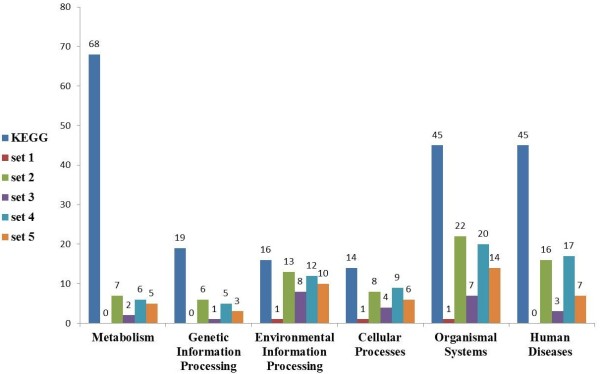
The distribution of KEGG pathways with modules among the main KEGG categories for parameter sets 1-5. The leftmost column in each category indicates the number of pathways containing 10-300 genes in the KEGG database [34], and columns 2-6 correspond to the resulting number of pathways for parameter sets 1-5, respectively.